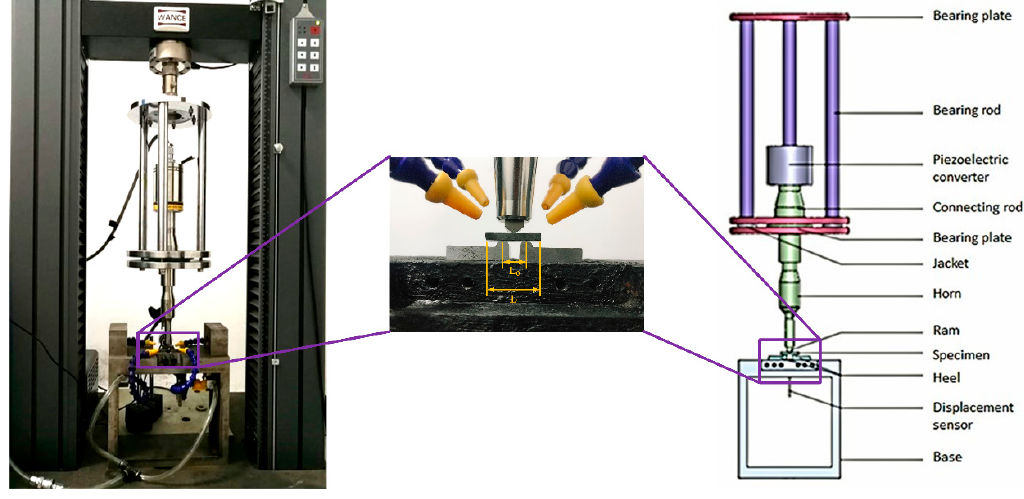
Figure 4. Ultrasonic three point bending fatigue test device.